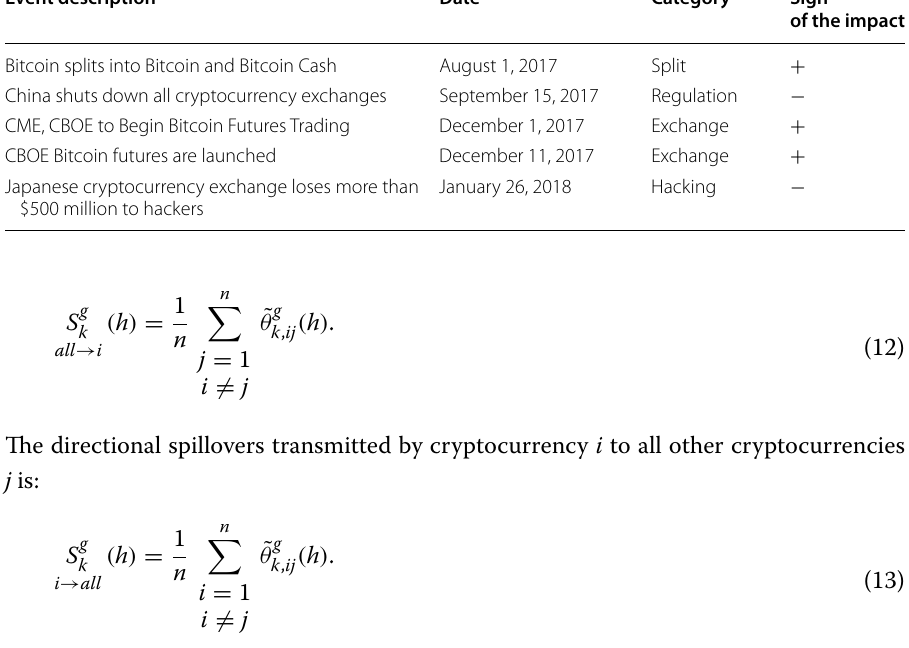
Table 1 Selected events related to the cryptocurrency markets Event